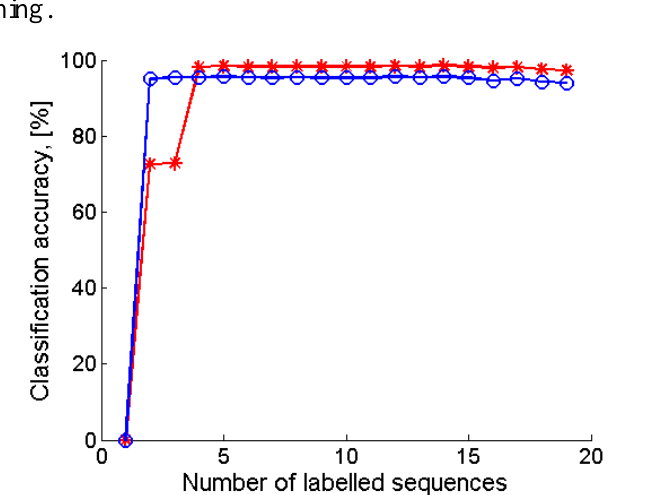
Figure 6. Classification accuracy vs. number of P of motor sentences in the training set. o: second-phase